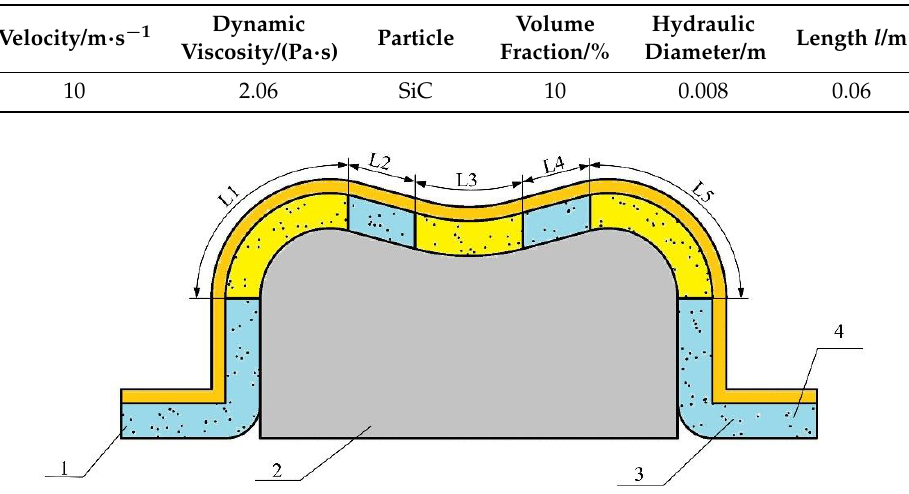
Table 1. Physical parameters of abrasive flow.